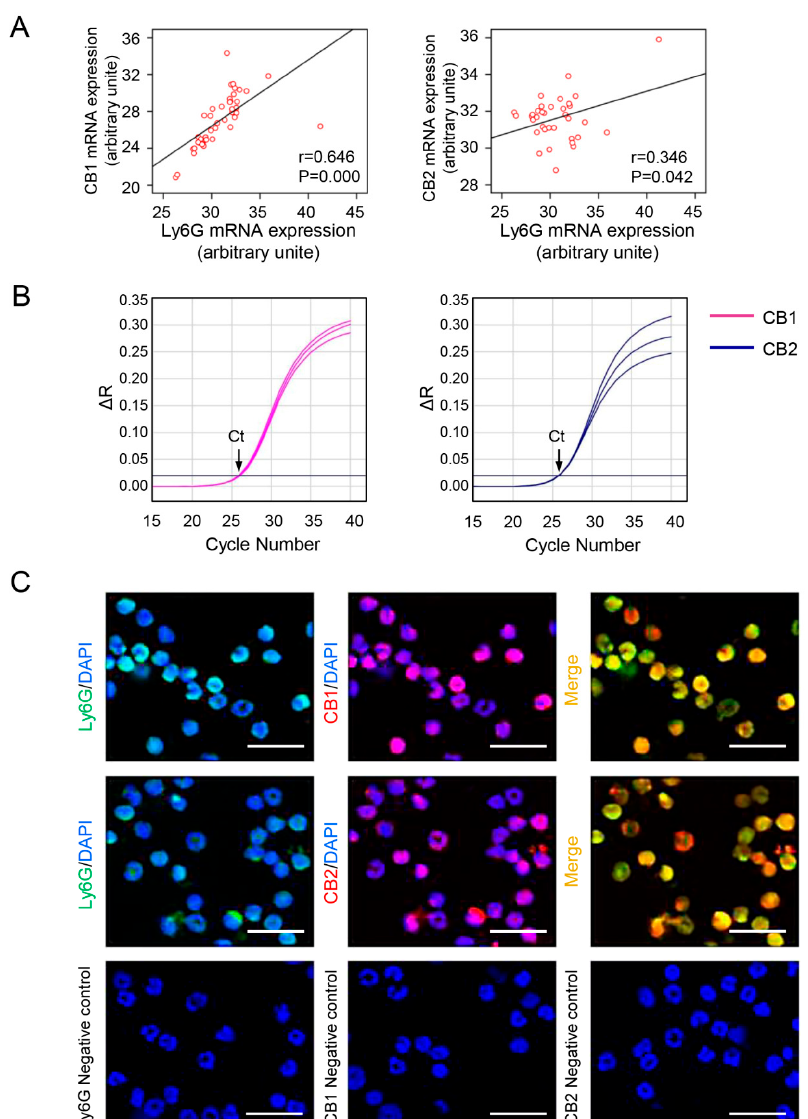
Figure 2. Cannabinoid receptor (CB) expression positively correlates with neutrophil signatures in CCl 4 -treated mice, and CBs are abundantly expressed in isolated neutrophils. ( A ) The correlation between Ly6G and CB1 or CB2 in liver tissue. ( B ) The amplification plots of CB1 and CB2 expression in neutrophils by RT-qPCR. ( C ) Representative images of immunofluorescent staining for Ly6G (green) and CB1 or CB2 (red) in neutrophils. The nuclei were stained with DAPI (blue). Scale bars, 20 µ m. N = 6 per group.